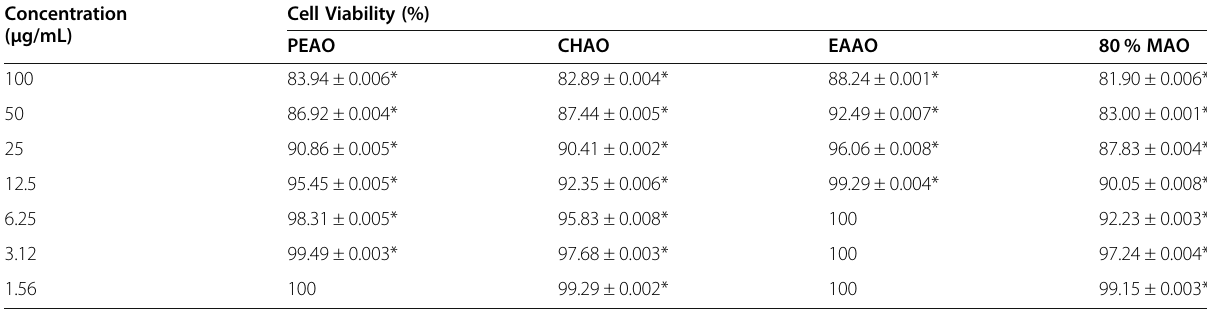
Table 3 Percentage Cell Viability of Petroleum ether, Chloroform, Ethyl acetate, and 80 % Methanolic Extracts of A. occidentale roots against MIN6 cells Concentration Cell Viability (%) (µg/mL)